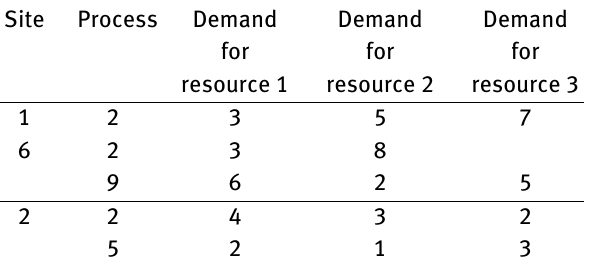
Table 1: Demanded number of resource units to complete construc- tion processes (examples and description in the text).